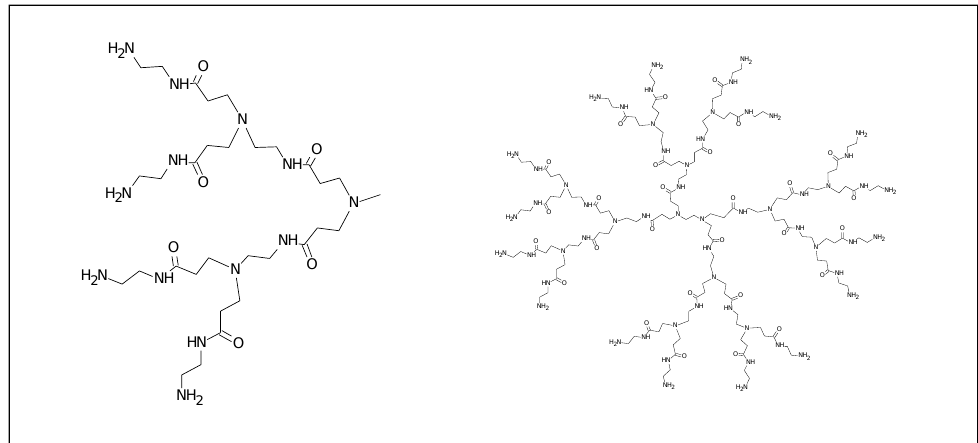
Figure 4. Schematic representation of micelle (right). Chemical structure of PEG-PE (left).